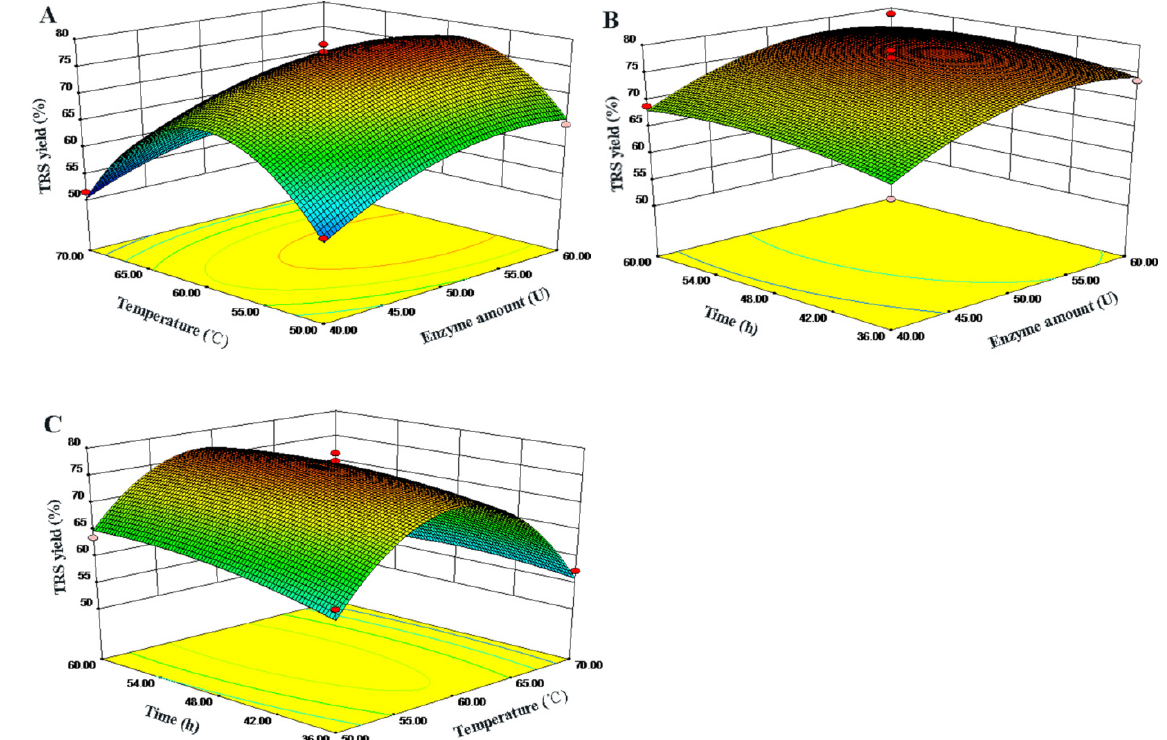
Figure 4. The 3D response surface plots showing the effects of temperature ( ◦ C), enzyme amount (U), and reaction time (h) on TRS yield. ( A ) shows the interaction between temperature ( ◦ C) and enzyme amount (U) on TRS yield; ( B ) shows the interaction between time (h) and enzyme amount (U) on TRS yield; ( C ) shows the interaction between time (h) and temperature ( ◦ C) on TRS yield.